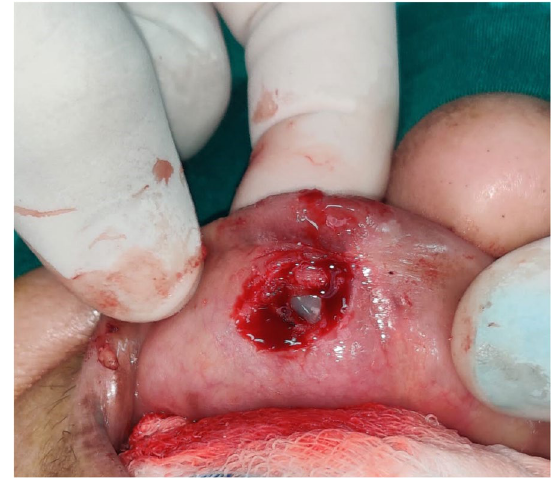
Fig. 4 Intraoperative photo—the broken tooth fragment is found embedded in the swelling. There was no surrounding fibrosis